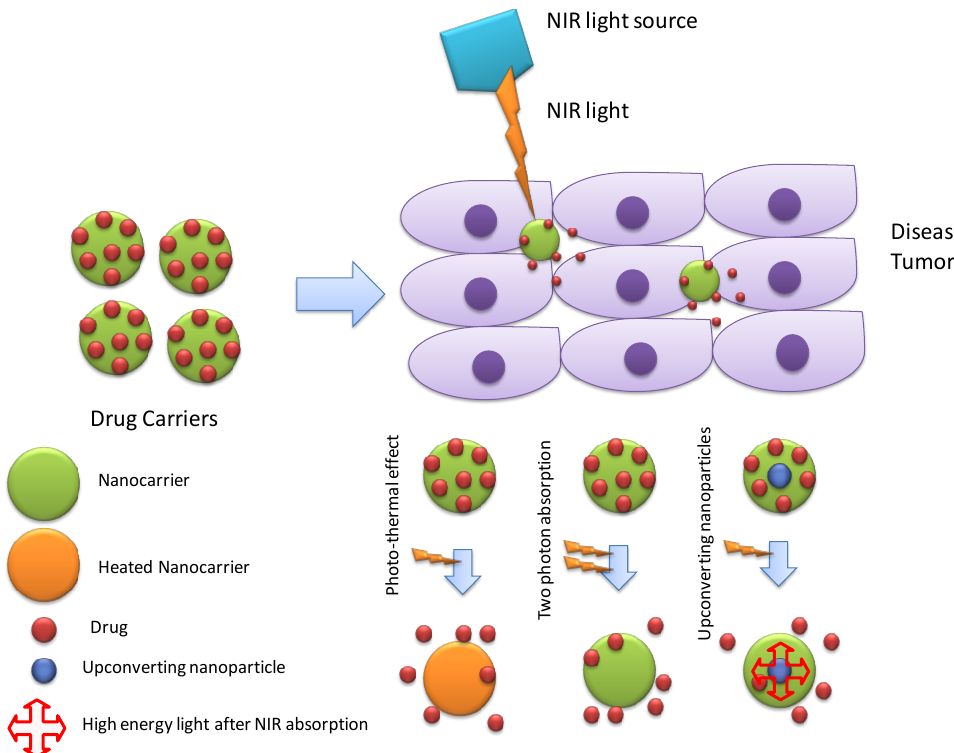
Figure 8. Mechanisms of drug release through NIR responsive DDSs.